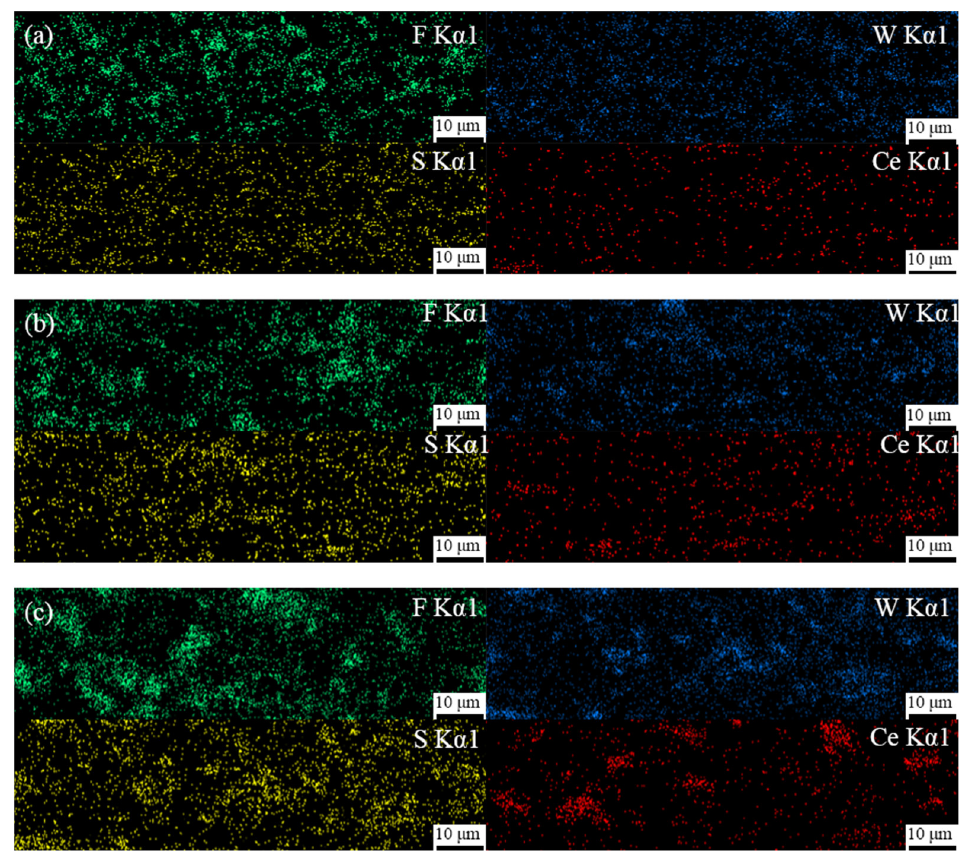
Figure 4. EDS scan results of composite coatings. ( a ) T1.5 coating; ( b ) T2 coating; ( c ) T2.5 coating.